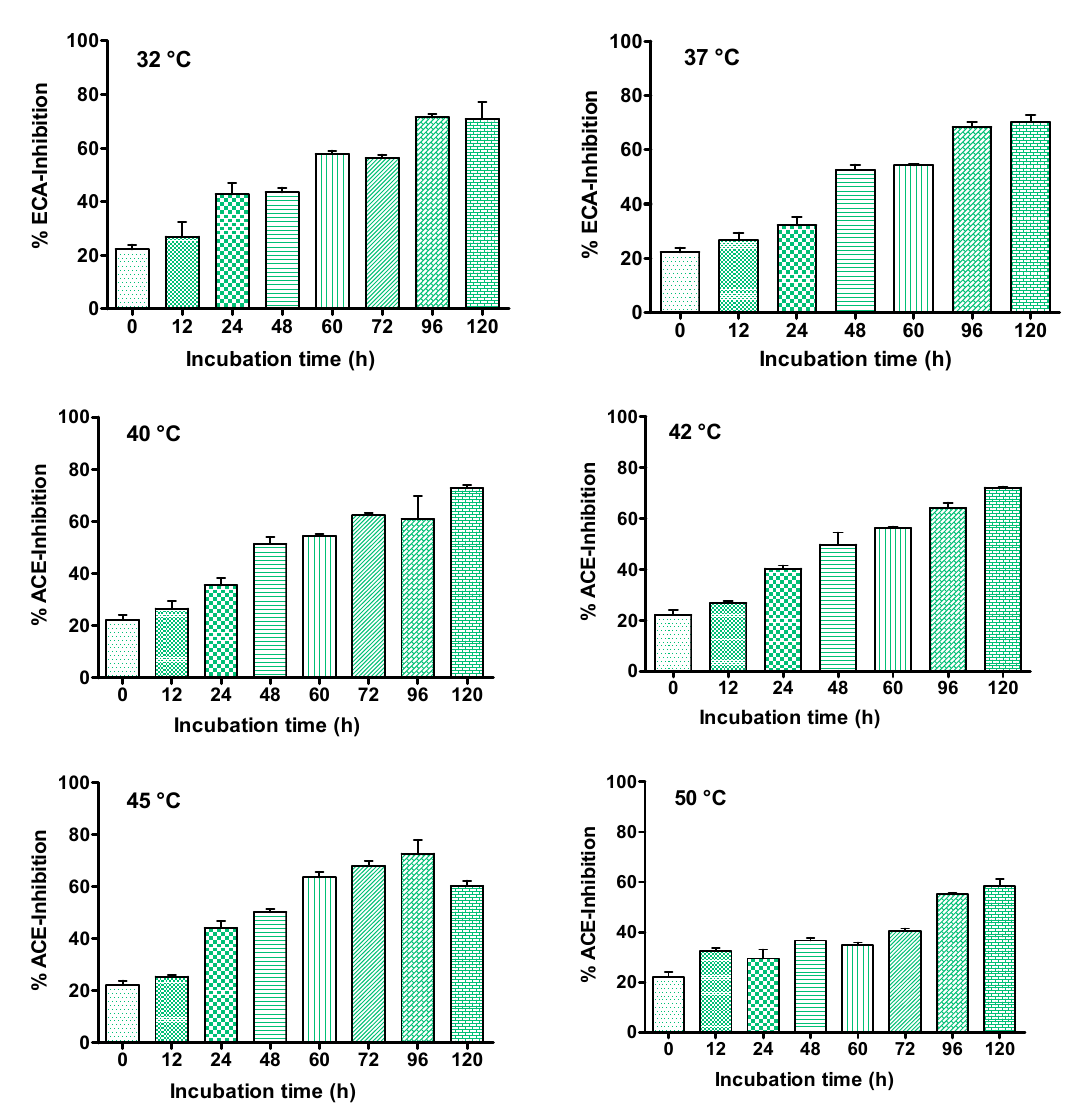
Figure 5. Effect of temperature on angiotensin-converting enzyme (ACE)-activity inhibition by peptide fractions < 10 kDa during whey fermentation by its native microbiota. Values are mean ± SD, n = 4.